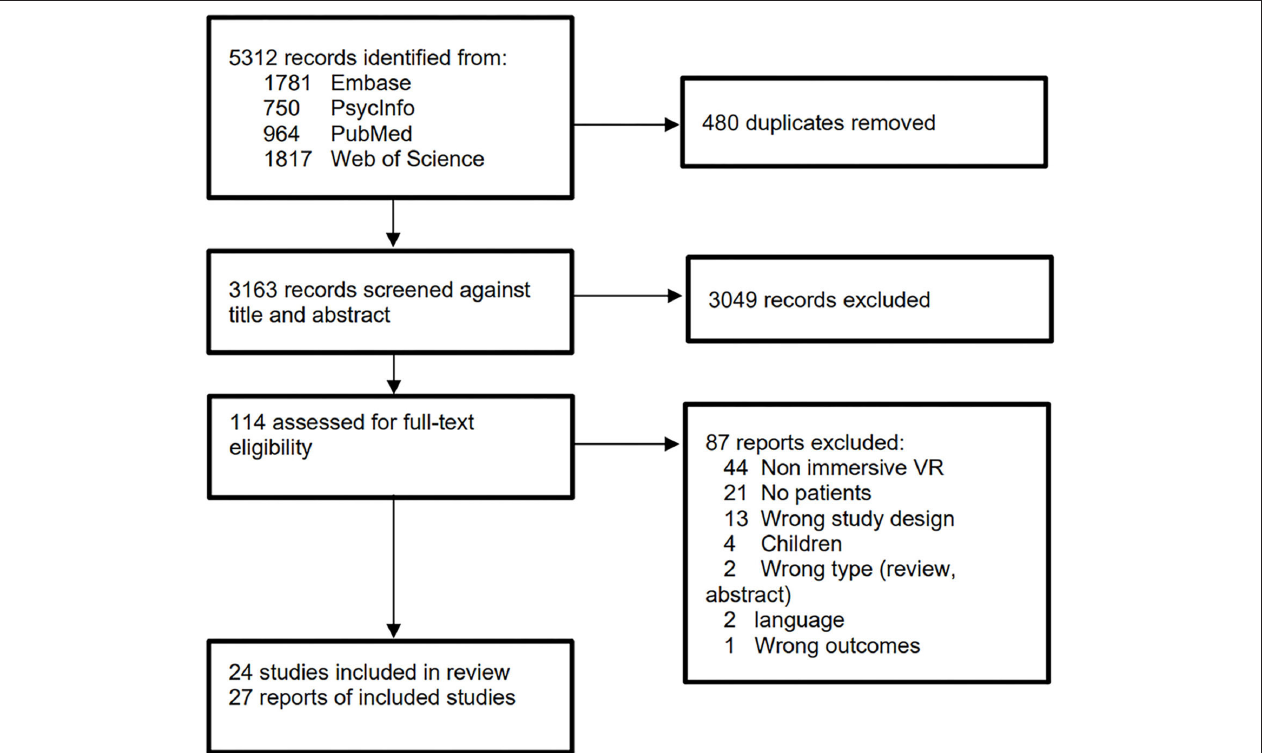
FIGURE 1 | Flow diagram of the study inclusion